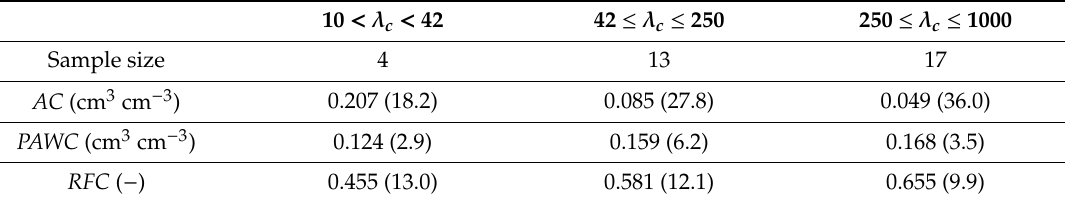
Table 4. Mean and associated coe ffi cient of variation (in brackets) of air capacity (AC), plant available water capacity (PAWC), and relative field capacity (RFC) obtained for three soil capillarity λ c (mm) classes (week, moderate, and strong, respectively).